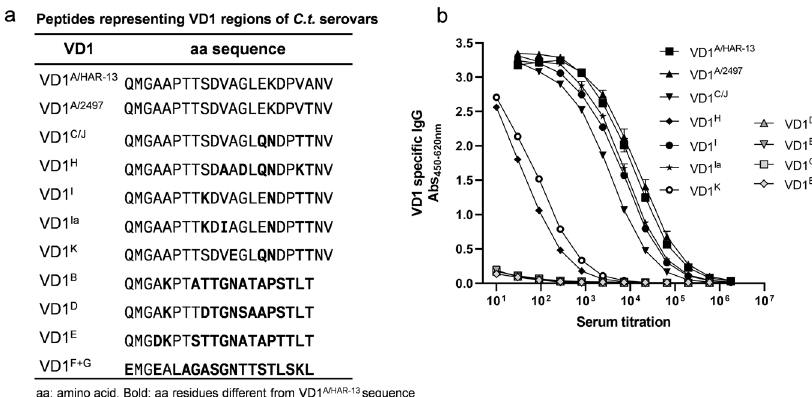
Fig. 5 Recognition of peptides representing the VD1 region of C.t . serovars with extVD1 A *4-speci fi c serum. A/J mice were immunized with extVD1 A *4/CAF01 ( n = 20) or CAF01 alone ( n = 20) using the SIM vaccination protocol. Three weeks after the 3rd vaccination, individual serum samples were pooled ( n = 20), serially diluted in triplicates, and added to peptide-coated plates representing the major part of the VD1 regions of C.t . SvA, SvC/J, SvH, SvI, SvIa, SvK, SvB, SvD, SvE, SvF, and SvG. Sequences of VD1 peptides ( a ). Peptide-speci fi c IgG was analyzed by ELISA ( b ). Each dot represents the mean OD value ± SD of triplicate readings at each titration